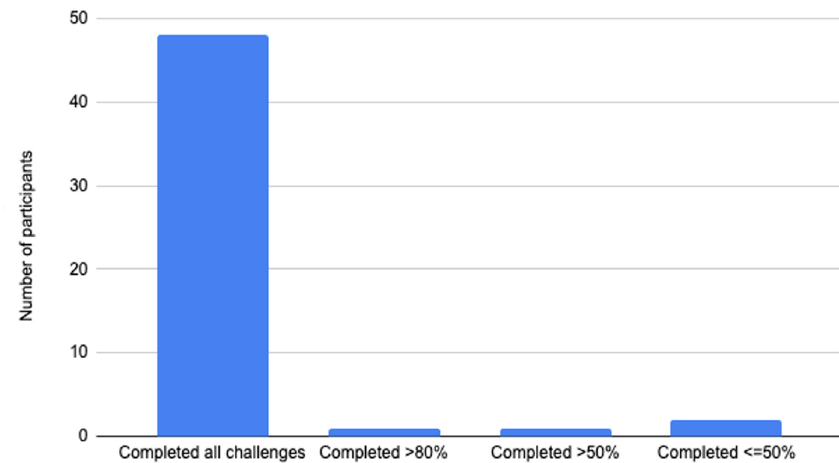
Figure 5. Participants’ engagement on the daily